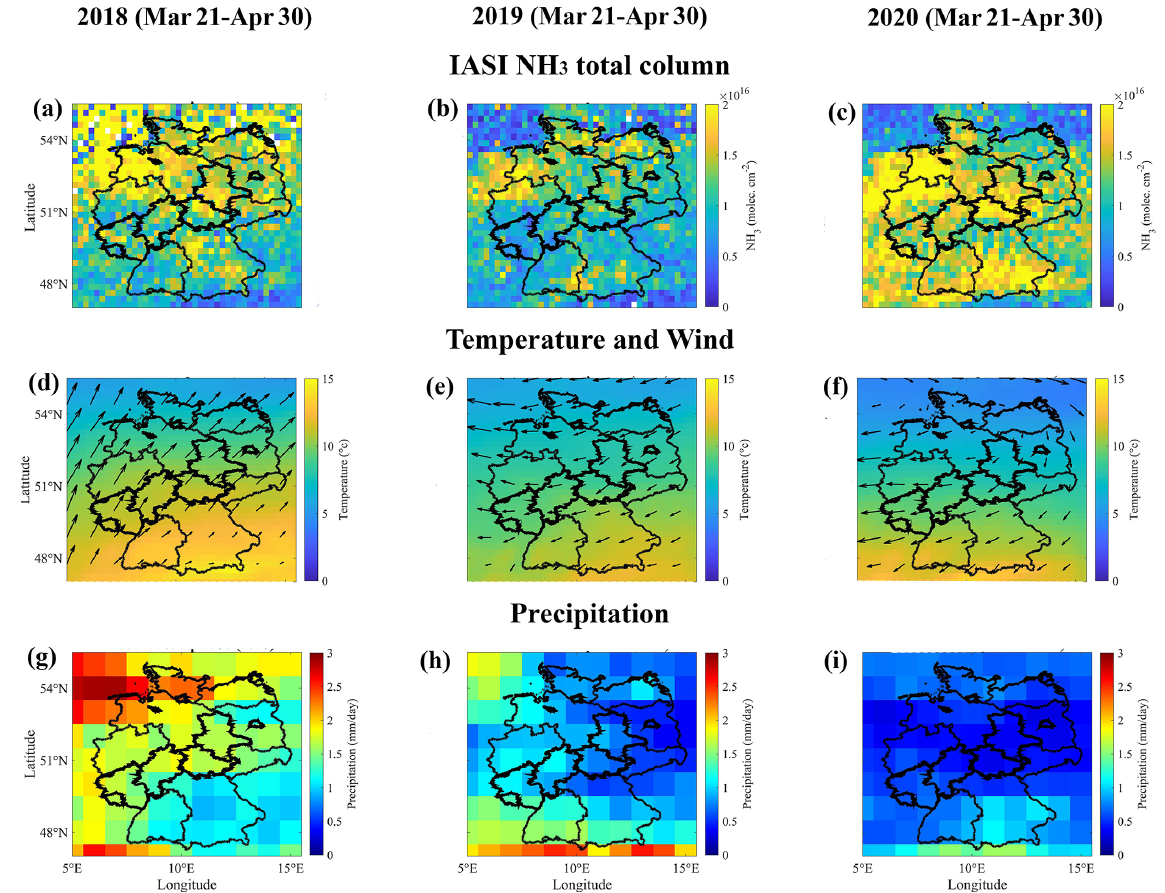
Figure 7. Mean IASI NH 3 total column (daily IASI NH 3 measurements gridded at 0.25 ◦ resolution) (top), mean temperature and wind (middle), and mean precipitation